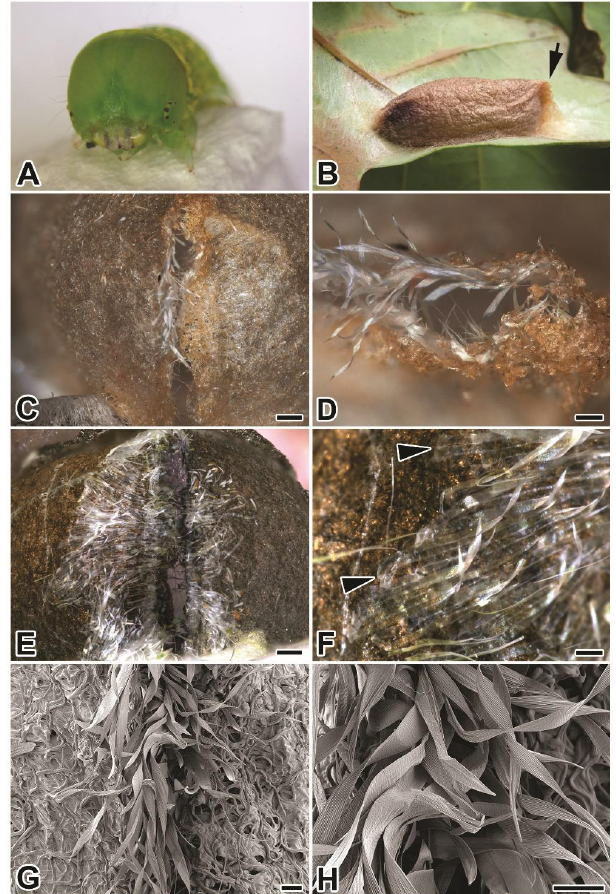
Figure 1. Pseudoips prasinana L. larva, cocoon and silk. ( A ) Last-instar larva. ( B ) Cocoon; arrow on the right points to the exit valve . ( C , D ) Outer and ( E , F ) inner side of the cocoon escape valve, examined using an optical microscope. ( F ) Arrowheads indicate the base of the newly detected silk type. ( G , H ) Scanning electron micrographs of the escape valve from the outside. Scale-bars : ( C , E ) 0.5 mm; ( D , F ) 0.2 mm; ( G , H ) 100 μm.